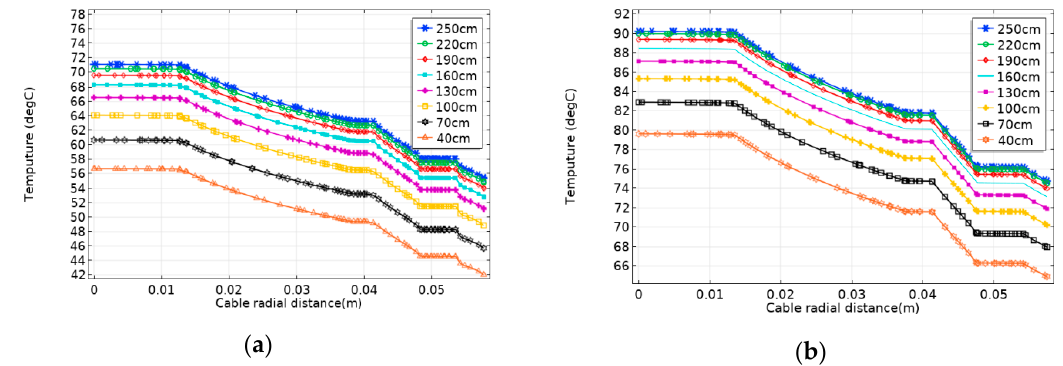
Figure 9. Changes in the radial temperature of the submarine cable for two laying methods with different laying depths. ( a ) Changes in the radial temperature of the submarine cable for direct burial laying with different laying depths. ( b ) Changes in the radial temperature of the submarine cable for pipe laying with different laying depths.